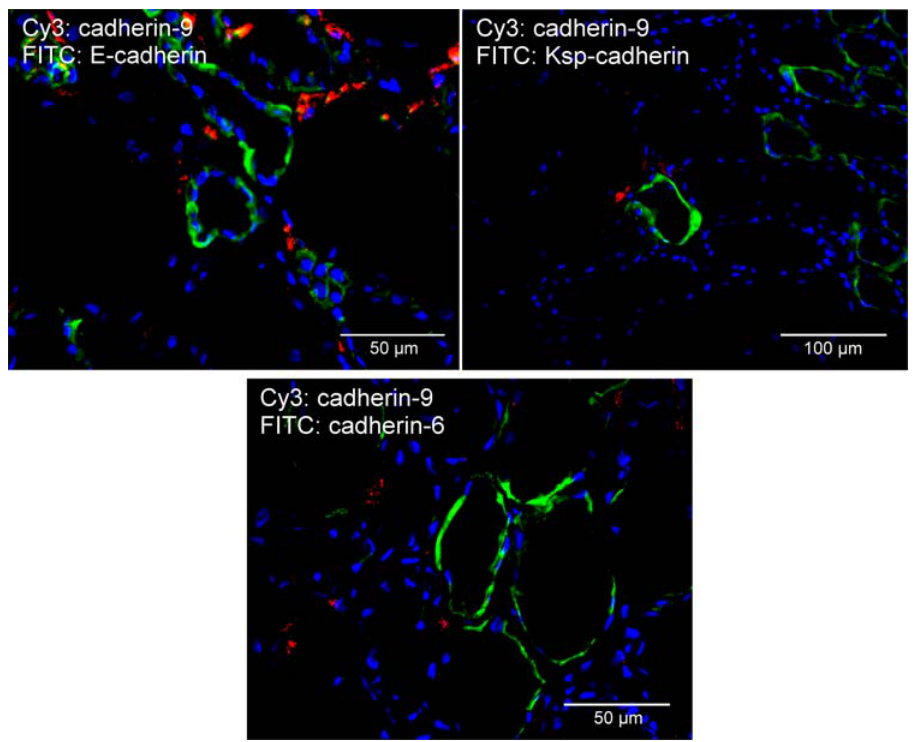
Figure 5. Localization of cadherin-9-positive cells in comparison to other cadherin expressing epithelial tubular cells. The micrographs show double immunofluorescence staining of a normal human kidney with the cadherin-9 antiserum and monoclonal antibodies against E-cadherin (A), Ksp-cadherin (B) and cadherin-6 (C), respectively. E-cadherin and Ksp-cadherin are marker molecules for distal tubules, whereas cadherin-6 is specifically expressed in proximal tubules. However, no preferential distribution of cadherin-9 expressing cells was detected with either proximal or distal tubular epithelial cells, nor any co-localization with the potential interaction partner cadherin-6 was observed. Bars: (A,C) 50 m m; (B) 100 m m.